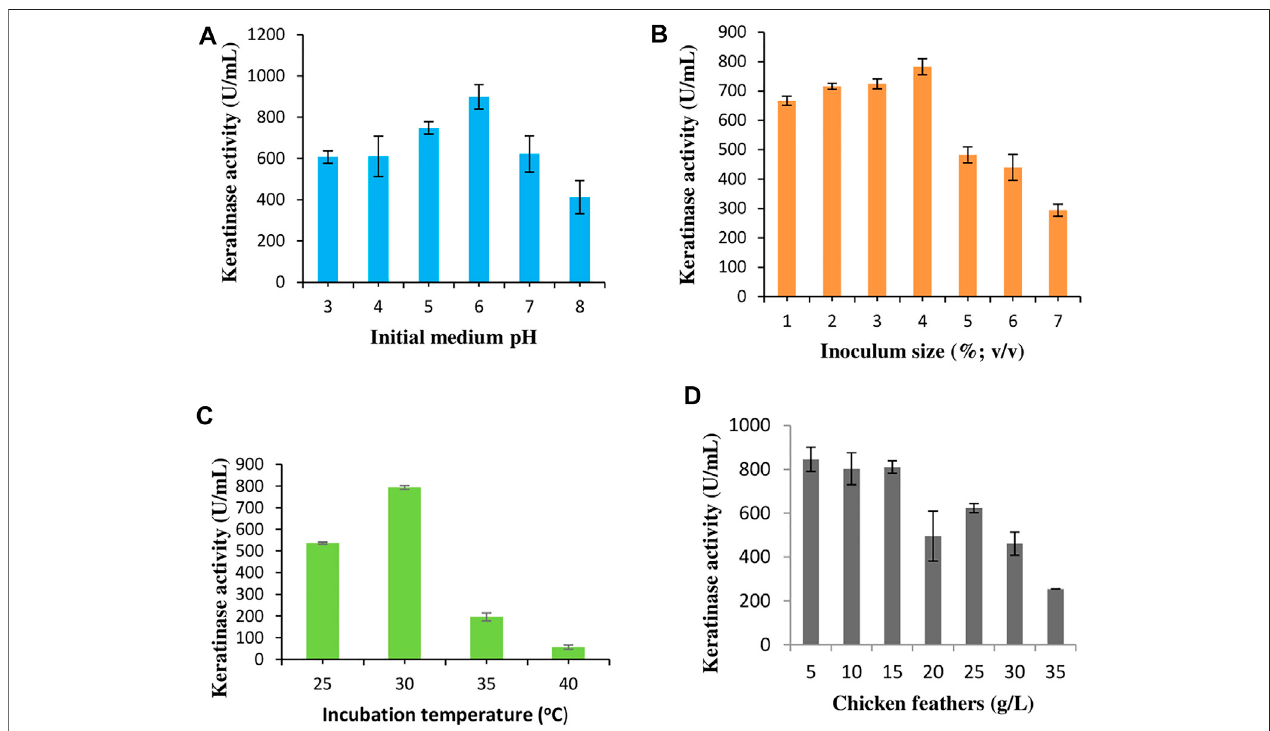
FIGURE 1 | The effect of process conditions (A) initial medium pH, (B) inoculum size, (C) incubation temperature, and (D) chicken feather concentration on keratinase production by C. aquifrigidense FANN1.